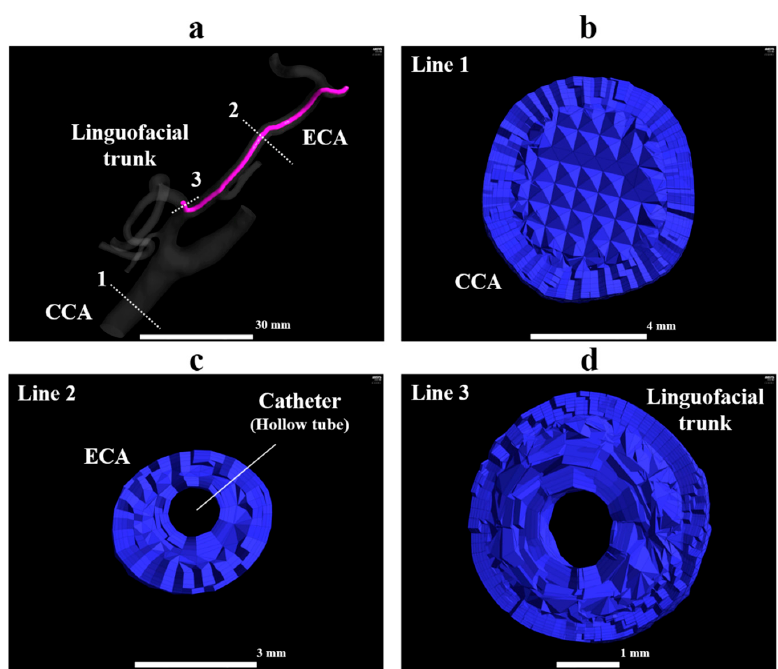
Figure 4. Tetrahedral and prismatic mesh in model A1. ( a ) The whole view of model A1, ( b ) the orthogonal view of the volume mesh at line 1, ( c ) the orthogonal view of the volume mesh at line 2, ( d ) the orthogonal view of the volume mesh at line 3. ECA, external carotid artery; FA, facial artery; LA, lingual artery.